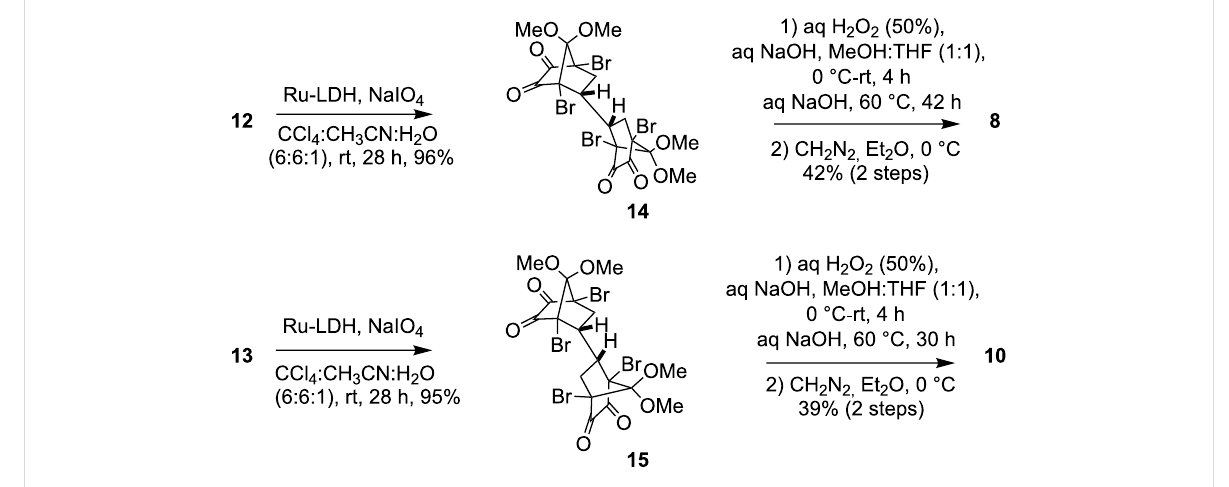
series ( 7 and 9 ), which required a phase transfer reagent (TBHSO 4 ), the bromo bis-diketones 14 and 15 underwent trans- formation to the bis-oxa-briged derivative 8 and 10 under the usual procedure previously reported from our laboratory [7] (Scheme 5). Although the yields in the final step were moderate (42 and 39%), this corresponds to 63–65% per oxa-bridge formed which is gratifying considering the number of interme- diates involved and possible side reactions.